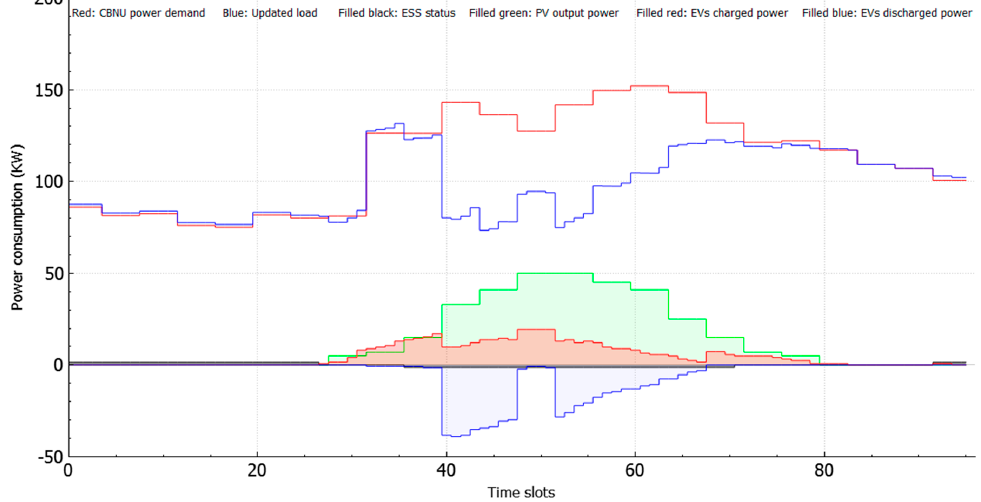
Figure 10. Results of scenario five with 150 EVs, a PV system of 50 kWh and an ESS of 80 kWh.